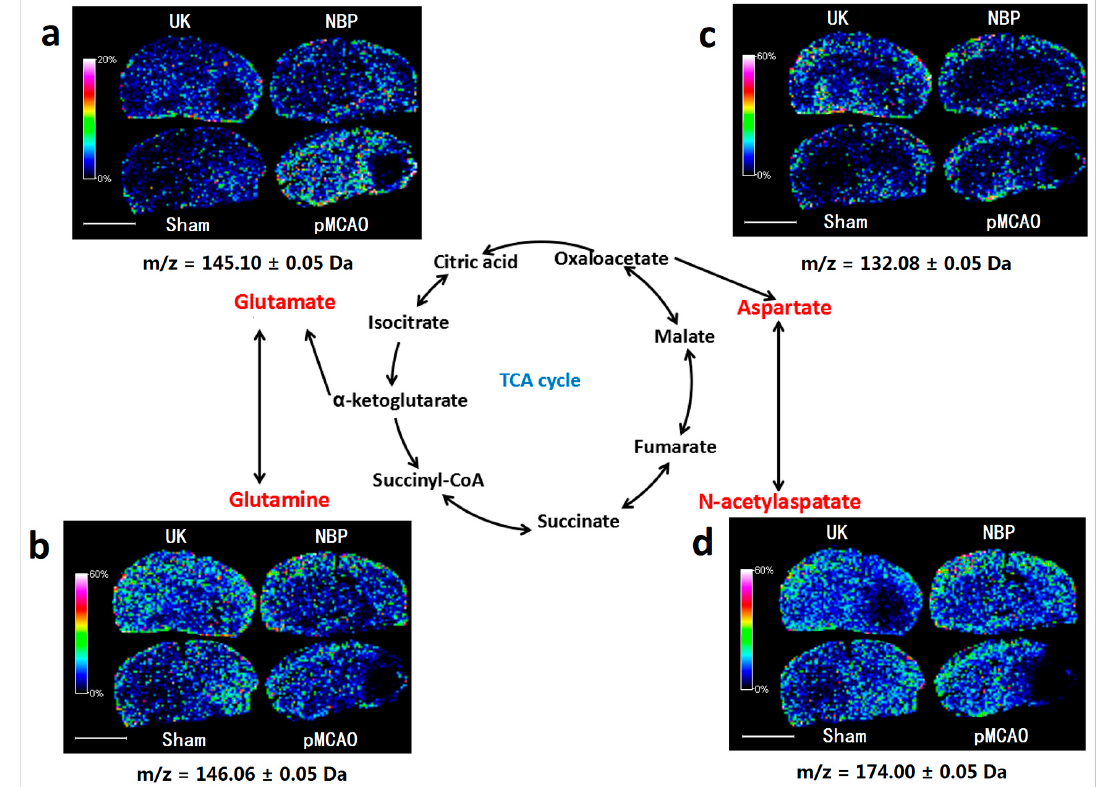
Figure 6. Dl-3-n-butylphthalide improved the levels of metabolites involved in the glutamate- glutamine cycle and the malate aspartate shuttle in the right cortex and striatum of pMCAO rats. MALDI–TOF–MS imaging of ( a ) glutamate; ( b ) glutamine; ( c ) aspartate and ( d ) N -acetylaspartate. The spatial resolution was set to 200 µ m. m/z : mass-to-charge ratio. Scale bar = 5 mm. n = 3. Sham: sham surgery group; pMCAO: pMCAO group; NBP: dl-3-n-butylphthalide-treated group; UK: urinary kallidinogenase-treated group.